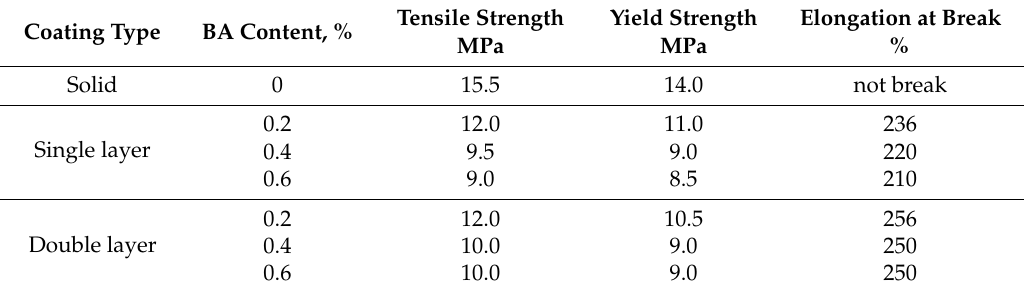
Table 2. Research results of the mechanical properties of coatings, average values with accuracy 0.5 MPa.